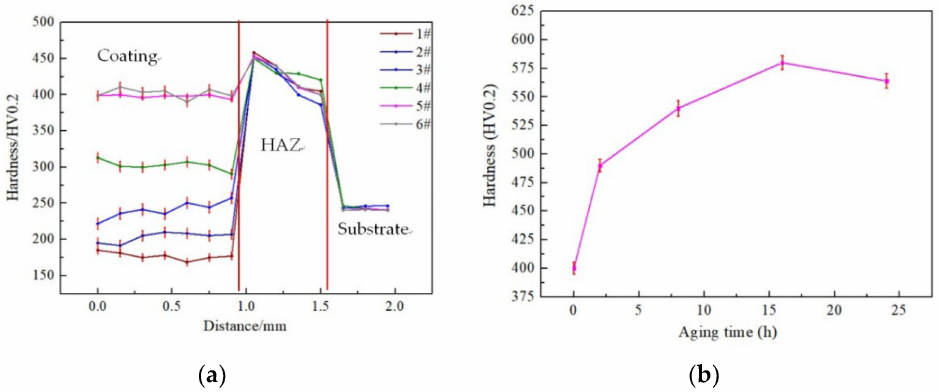
Figure 23. Micro-hardness of ( a ) different cladding layers and ( b ) Cladding layer 5# after aging treatment.